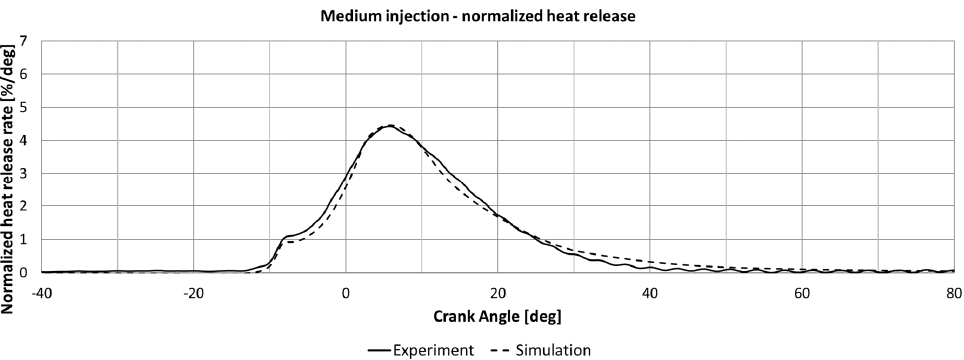
Figure 14. Measured and simulated rates, medium injection timing.